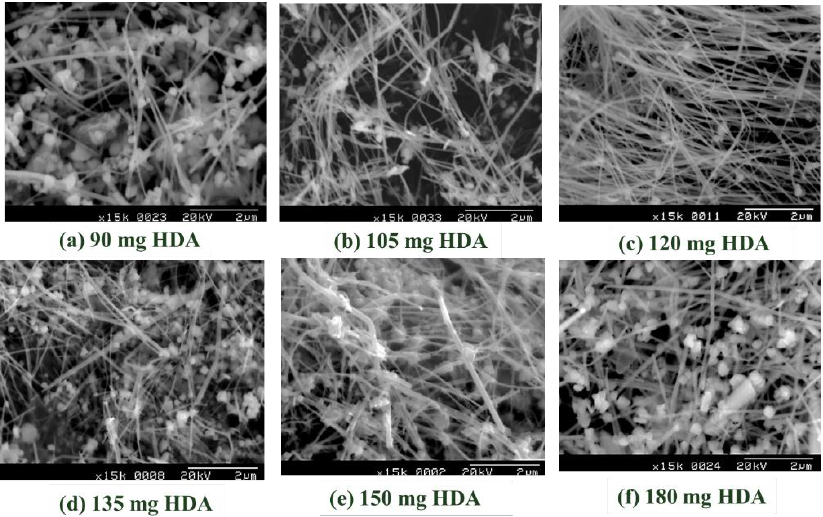
Figure 3. The SEM results of capping agent HAD content dependence on the morphology of copper nanowires. copper